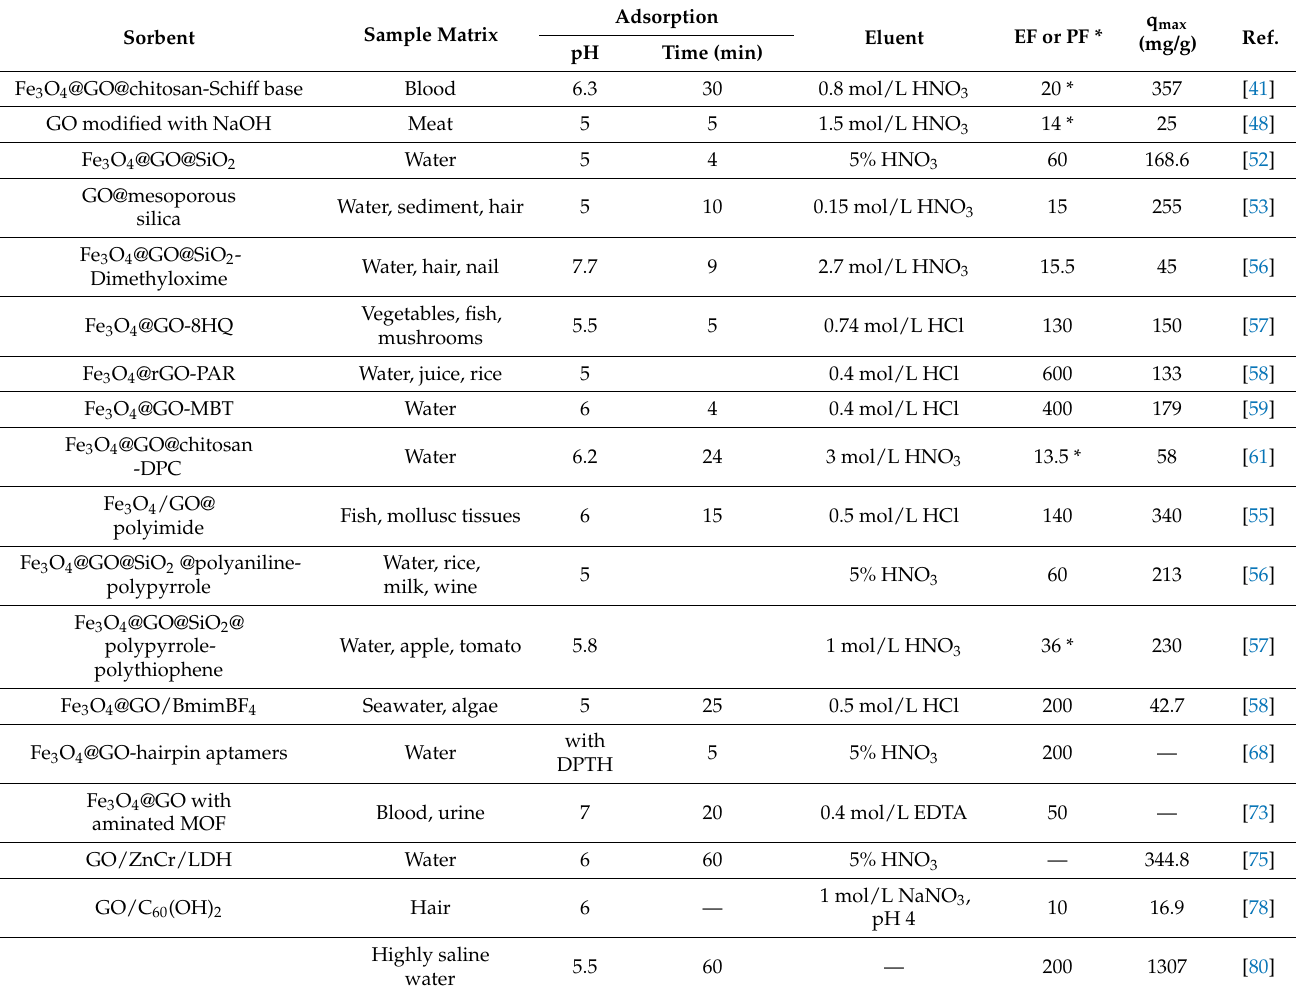
Table 1. The examples of the recent applications of graphene-based materials for the preconcentration of Pb(II) using SPE